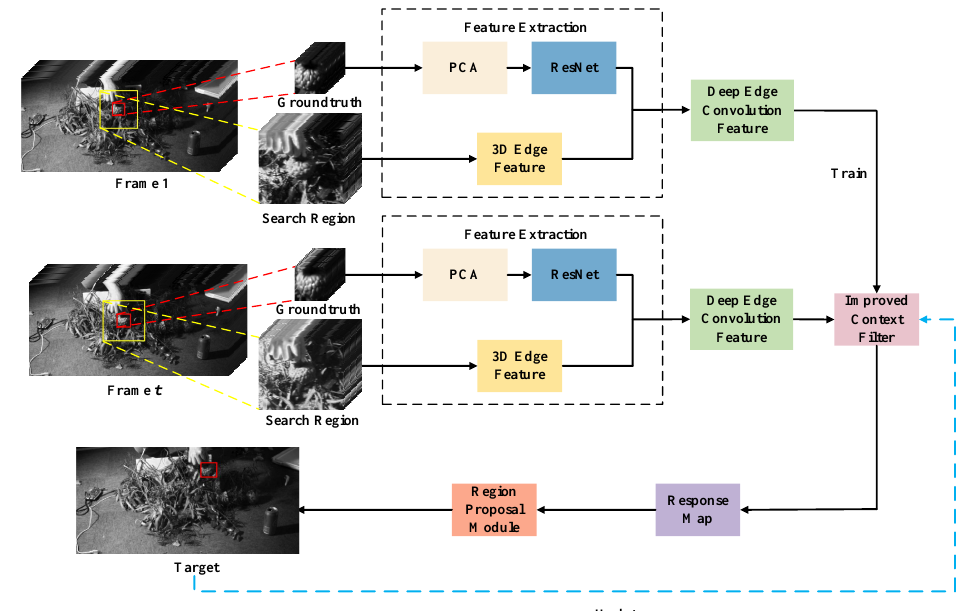
Figure 1. The framework of our